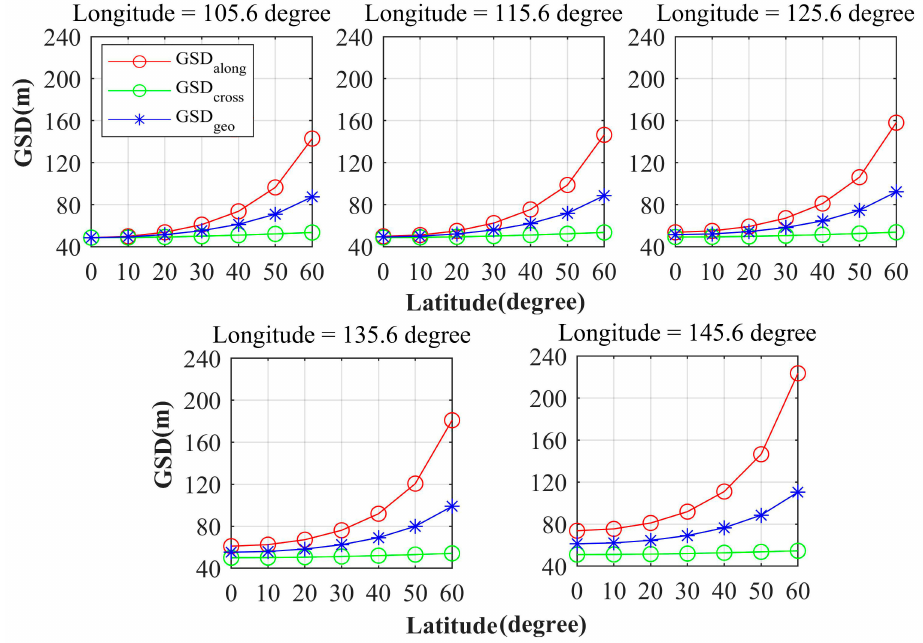
Figure 3. The variation of GSD with latitude and